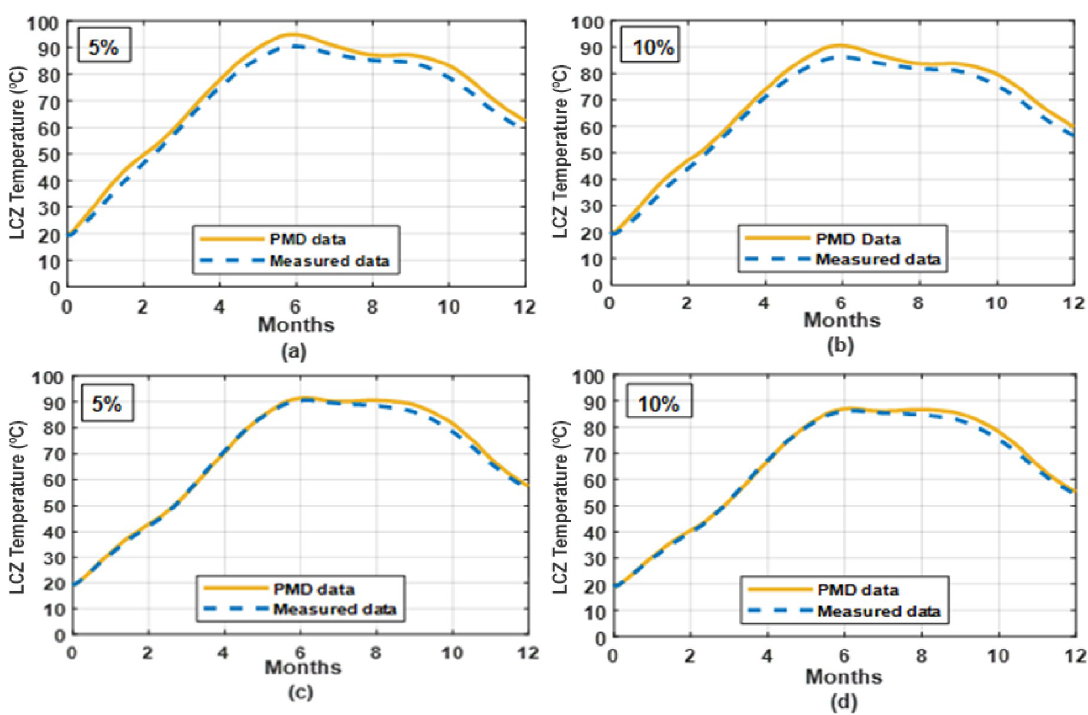
Fig 7. LCZ temperature with different moisture contents in soil under the solar pond for whole year simulation under PMD and measured climatic conditions of Lahore (a), (b) and Islamabad (c), (d).